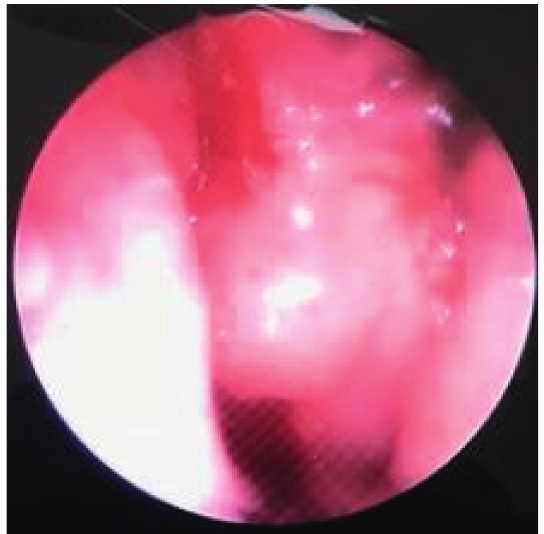
Figure 1: Flexible nasopharyngoscopy showing the polypoid mass in the nasopharynx.